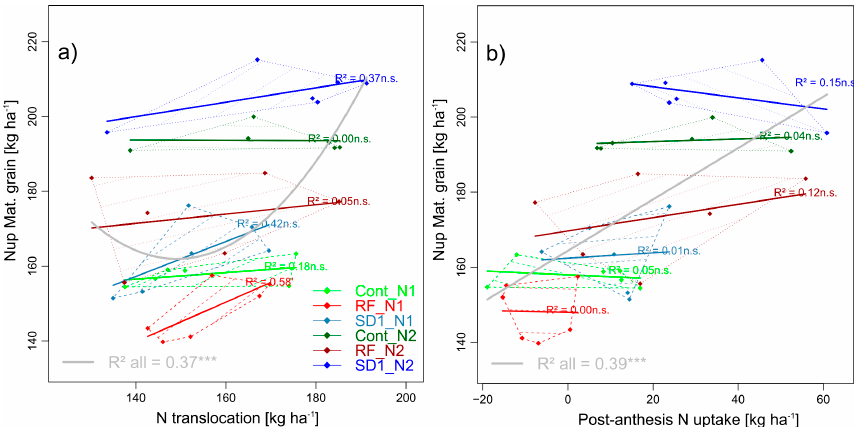
Figure 6. Selected pairwise trait relationships in trait complex g : Nup of grain at maturity (GNup) by its two additive components N translocation (NT, ( a )) and post-anthesis N uptake (PANup, ( b )). N levels are distinguished by line types and color intensities (N1: Dashed lines and light colors, N2: Dotted lines and dark colors). Dashed and dotted lines delimit the bivariate data range covered by cultivars within MP × N-combinations. Colored regression lines indicate the linear trait relationships within MP × N-combinations and gray lines the regression line for the whole trial, calculated across the included data of reduced fungicide (RF), control (Cont) and sowing date 1 (SD1). Gray lines are only drawn for significant relationships ( p < 0.05). P -values of regression slopes are indicated as p < 0.01 (***), p < 0.01(**), p < 0.05 (*) and p < 0.1 (´).